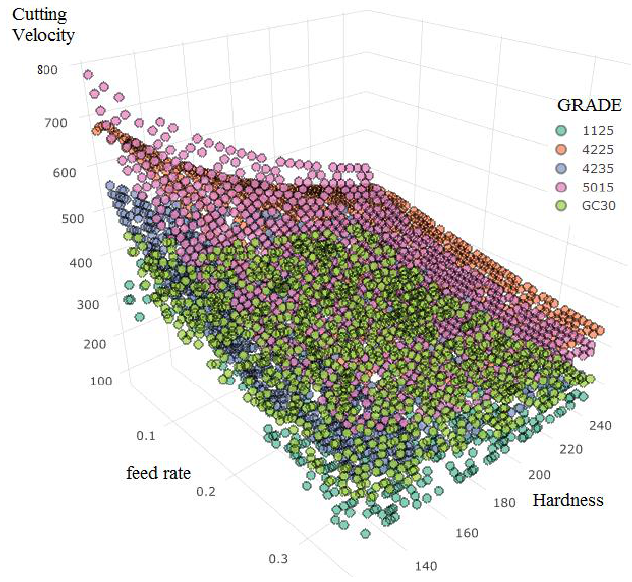
Figure 2. Cutting velocity, hardness and feed rate scatter.